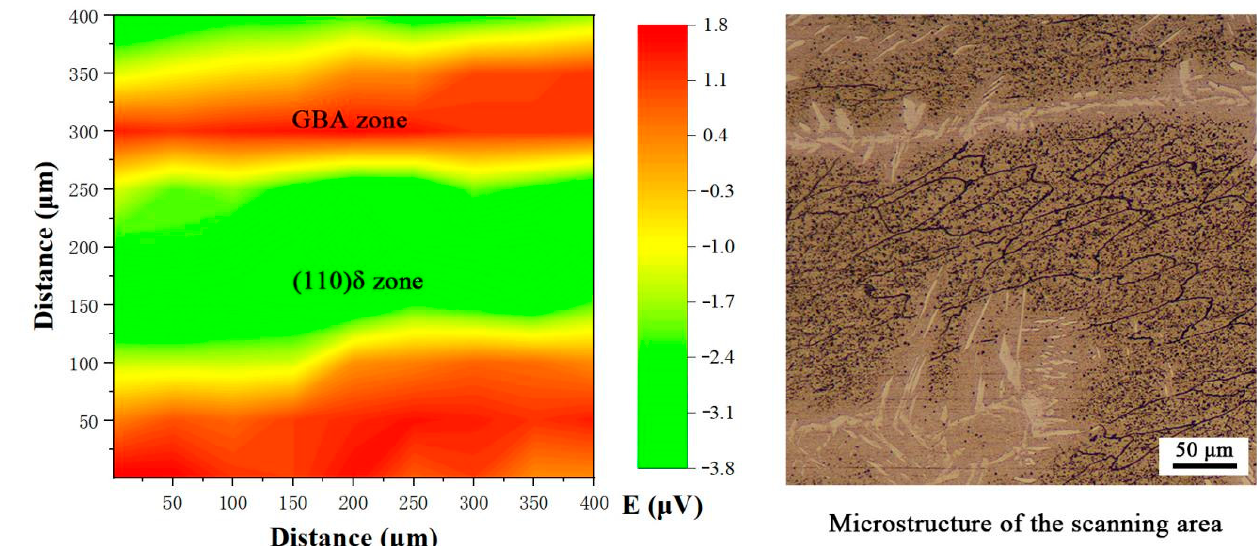
Figure 12. SVET result of the two-phase-coupled specimen in 3.5 wt.% NaCl solution.